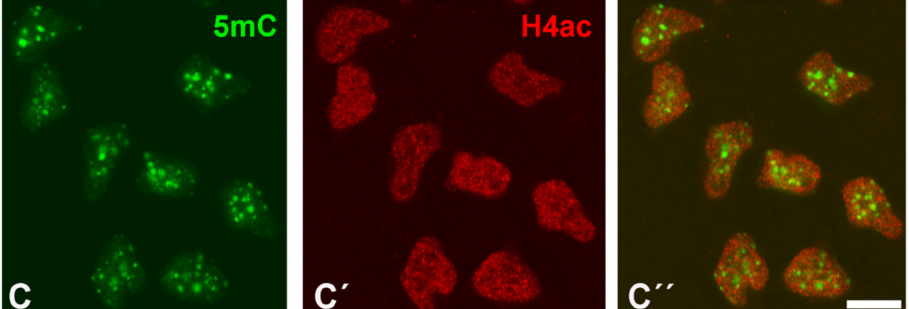
Figure 2. Immunolabeling of H3K9ac ( A’ , A” ), H3.3 ( B’ , B” ), and H4ac ( C’ , C” ) (red labeling), in combination with 5mC (green labeling, A , B , C ) in dissociated cells from the third interdigits of leg buds at id 6 (stage 29 HH). Note that H3K9ac ( A – A” ) and H4ac ( C – C” ) show a diffuse nuclear distribution that does not occupy zones of DNA methylation positive for 5mC immunolabeling ( A – C ). Differently from H3K9ac and H4ac, H3.3 ( B’ , B” ) also shows diffuse labeling within the nucleoplasm but overlapping in some zones (arrows in B” ) with 5mC marks. ( A” , B” , C” ) are merged images. Magnification bars = 5 µ m.